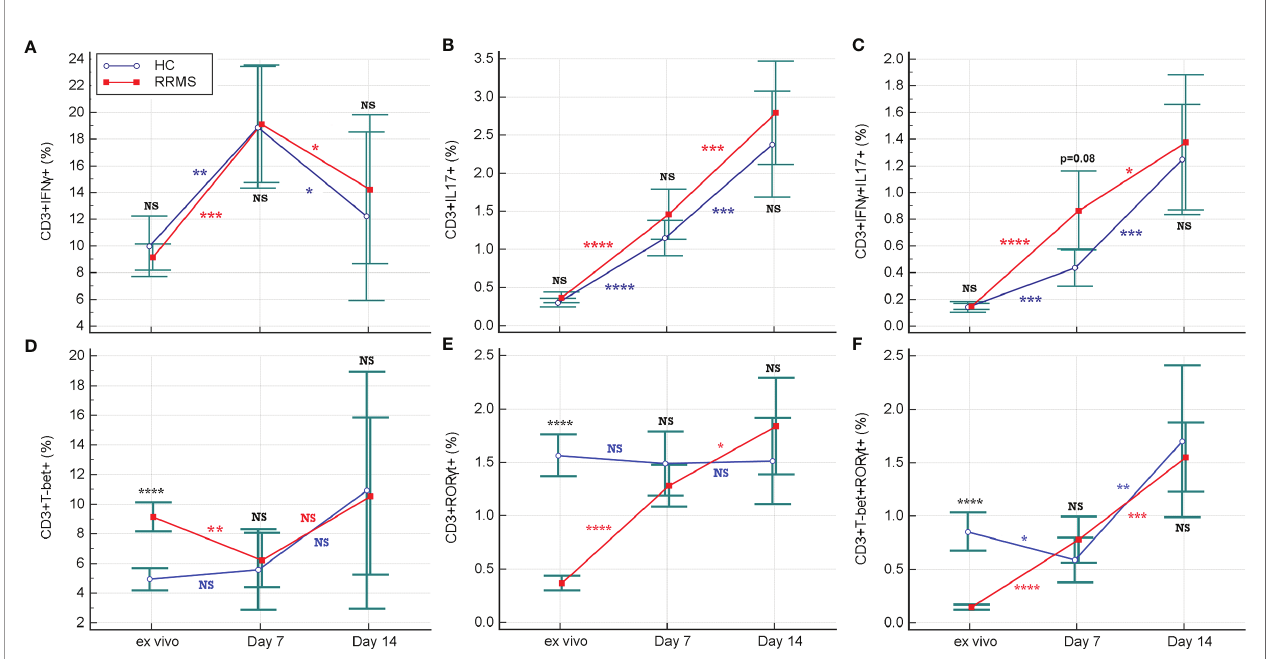
FIGURE 6 | Changes in the proportion of CD3+IFN g + and CD3+TBet+ (A, D) , CD3+IFN g +IL17+ and CD3+TBet+ROR g t+ (B, E) , CD3+IL17+ and CD3+ROR g t+ (C, F) cell subpopulations from ex vivo stage to days 7 and 14 of culture with rh-IL2. Signi fi cance levels are graphically presented as follows: NS, non signi fi cant, p >0.05,* p <0.05, ** p <0.01, *** p <0.001, **** p